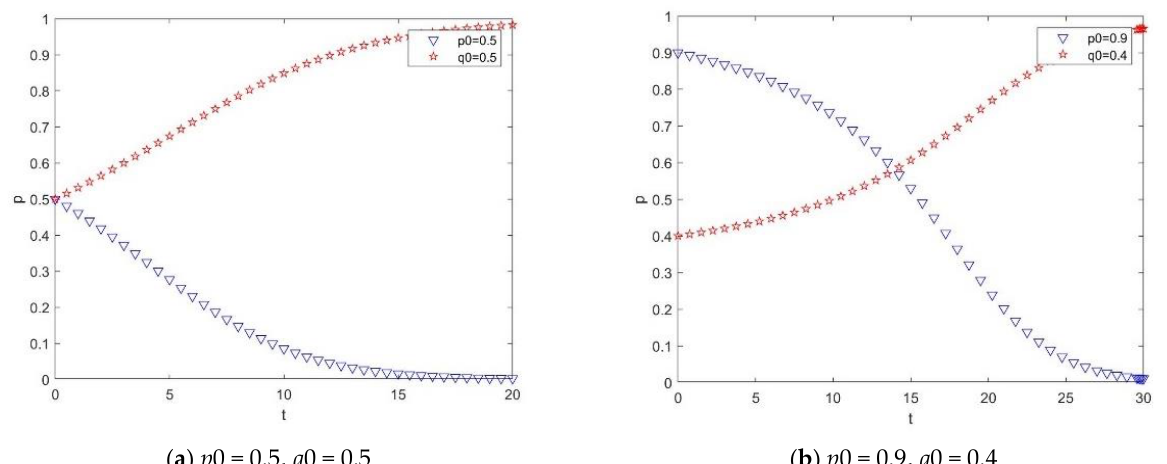
Figure 9. The effect of the change in the fine K on the evolution results. These results show that increasing the fine K is not effective in improving construc- tion safety. When the main contractor faces high fines, the main contractor is bound to exercise strict supervision and increase fines for the violations of construction workers.